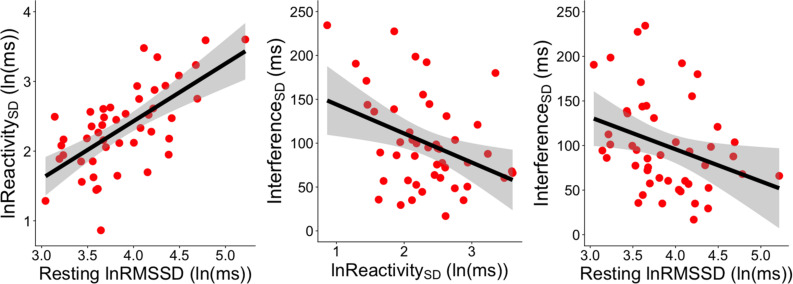
Significant correlations between RMSSD metrics and InterferenceSD. The left panel shows the correlation between resting lnRMSSD and the SD of RMSSD reactivity scores [ReactivitySD]. The middle panel shows the correlation between the SD of RMSSD reactivity scores [ReactivitySD] and the SD of RT interference scores across socioemotional conditions [InterferenceSD]. The right panel depicts the correlation between resting lnRMSSD and the SD of RT interference scores across socioemotional conditions [InterferenceSD]. RMSSD reactivity is defined as task RMSSD - BL RMSSD. RT interference is defined as incongruent RT - congruent RT. Each scatterpoint represents a single subject. Shaded regions indicate 95% confidence bands.